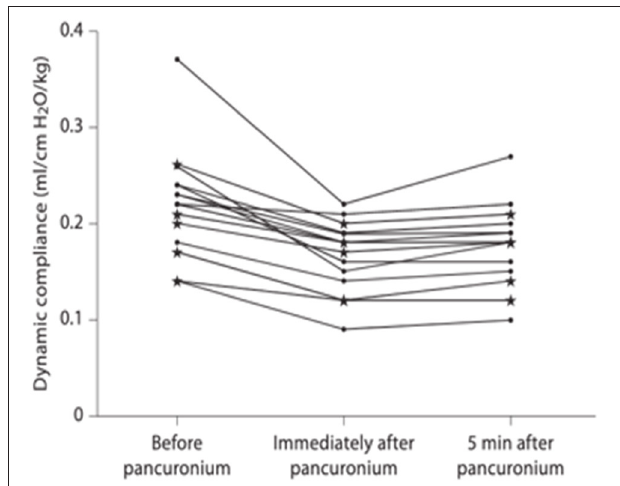
FIGURE 1 | Dynamic compliance immediately before, immediately after and 5min after pancuronium bromide administration [taken from (